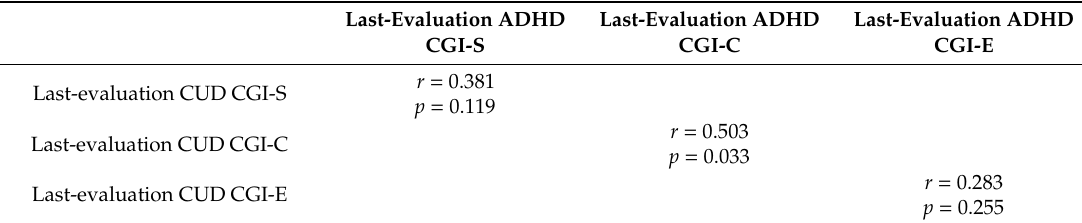
Table 3. Partial correlations* between ADHD-CUD last-evaluation CGI indexes corrected by the baseline ADHD-CUD severity